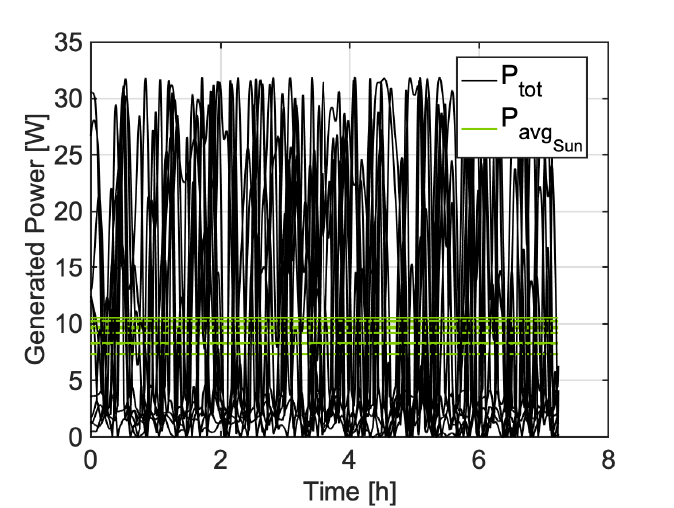
Figure 12. Solar arrays power Monte Carlo analysis, with no control